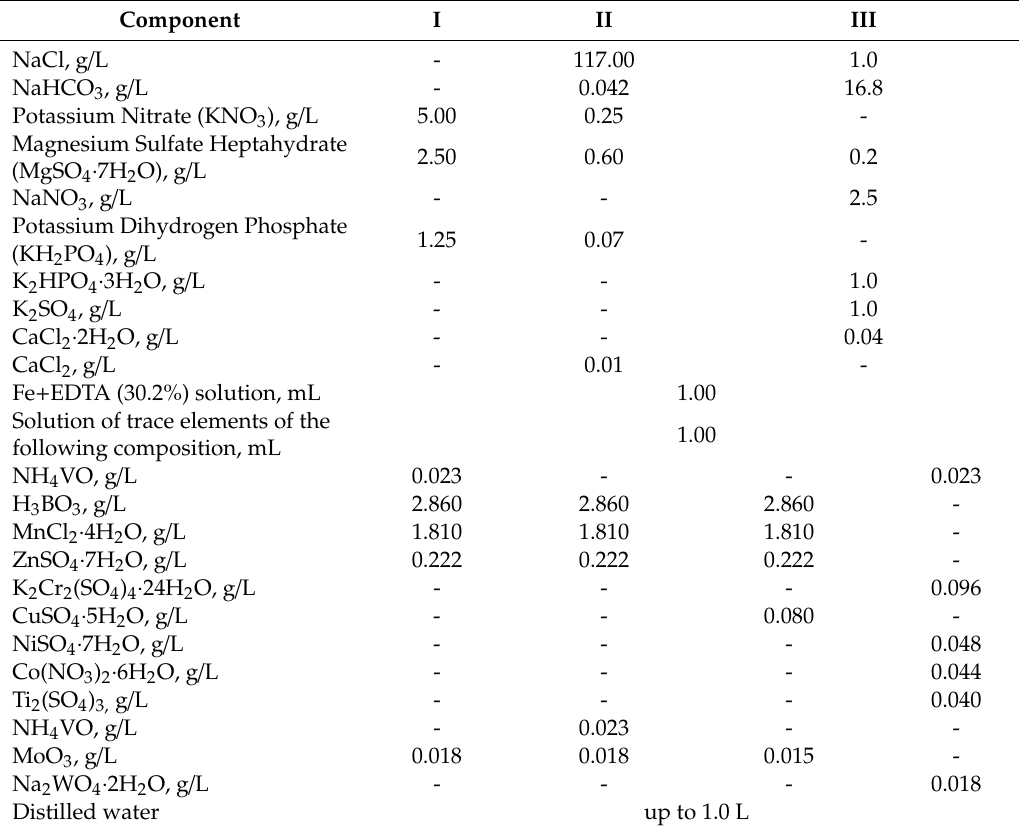
Table 1. Composition of nutrient medium for